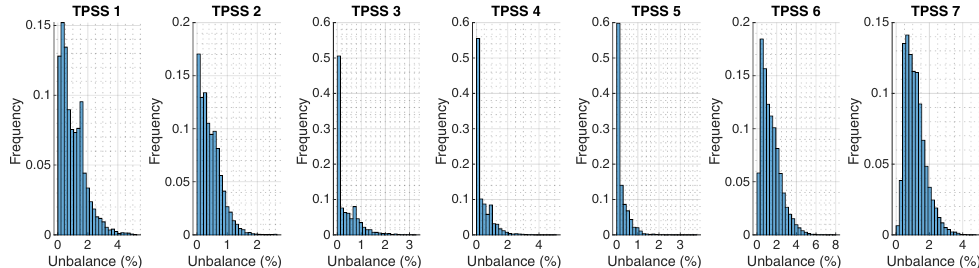
Figure 8. Voltage unbalance factor histograms corresponding to TPSS 1 to TPSS 7. The seven substations constituting the railway line have different V UF profiles, with